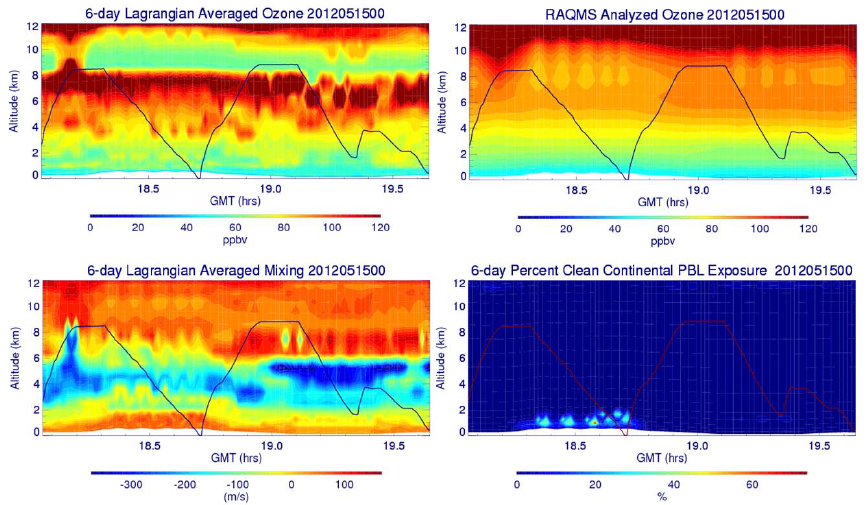
Fig. 4. RAQMS RDF O 3 (ppbv, upper left), analyzed O 3 (ppbv, upper right), RDF mixing efficiency (ms − 1 , lower left), and % clean continental PBL exposure (%, lower right) for AJAX flight on 14 May